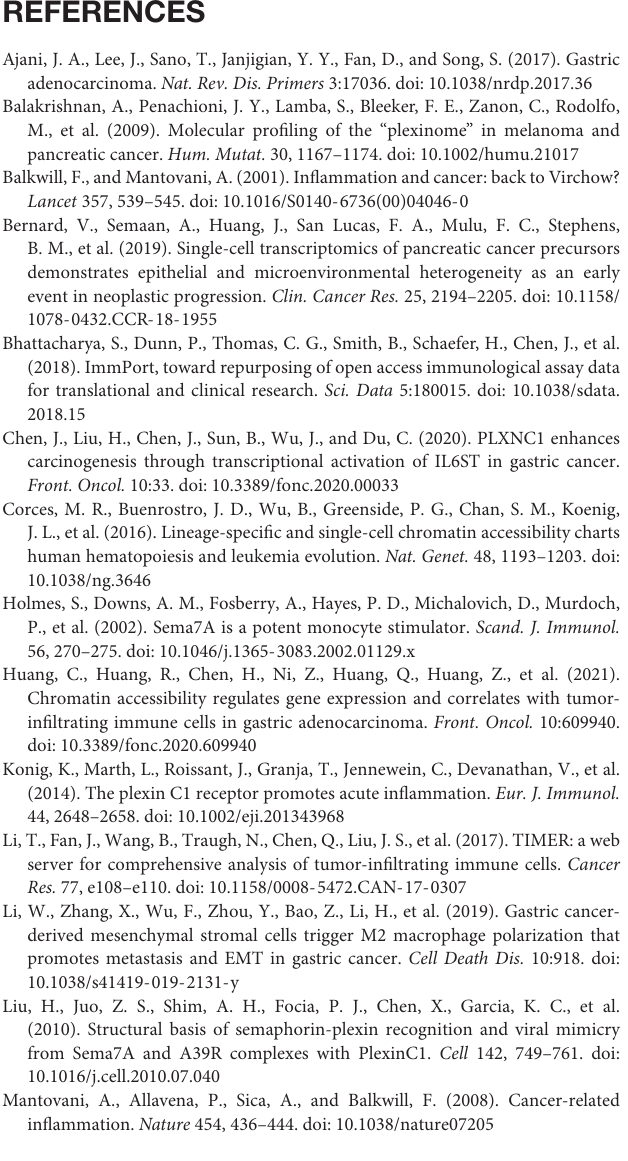
Supplementary Table 9 | The acronyms are defined in